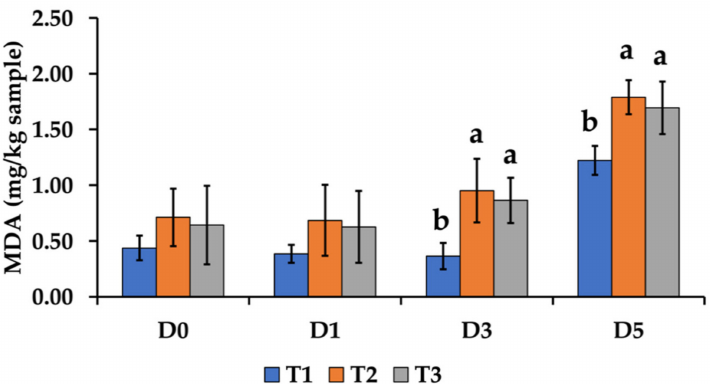
Figure 1. The illustration showed the marbling characteristics of pork loin from finishing crossbred pigs fed a low-lysine diet supplemented with perilla cake. T1, 0% perilla cake (PC); T2, 2.5% PC supplementation; T3, 4.5% PC supplementation.